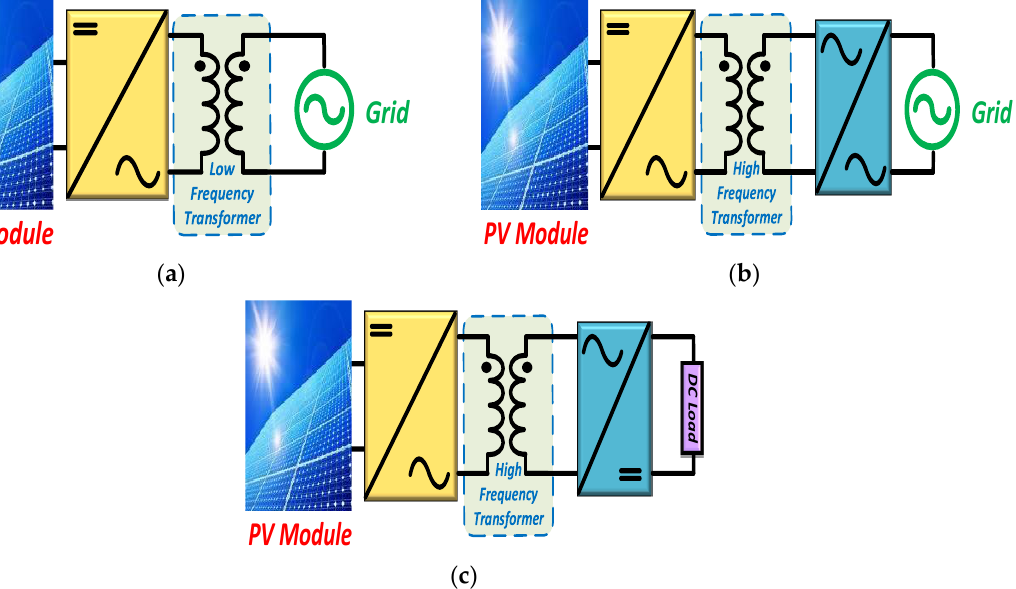
Figure 3. ( a ) Placement of the line-frequency transformer between the inverter and the grid. ( b ) HF-link grid-connected as/ac inverter. ( c ) A High-frequency transformer is embedded in a DC-link PV-module-connected DC-DC converter .